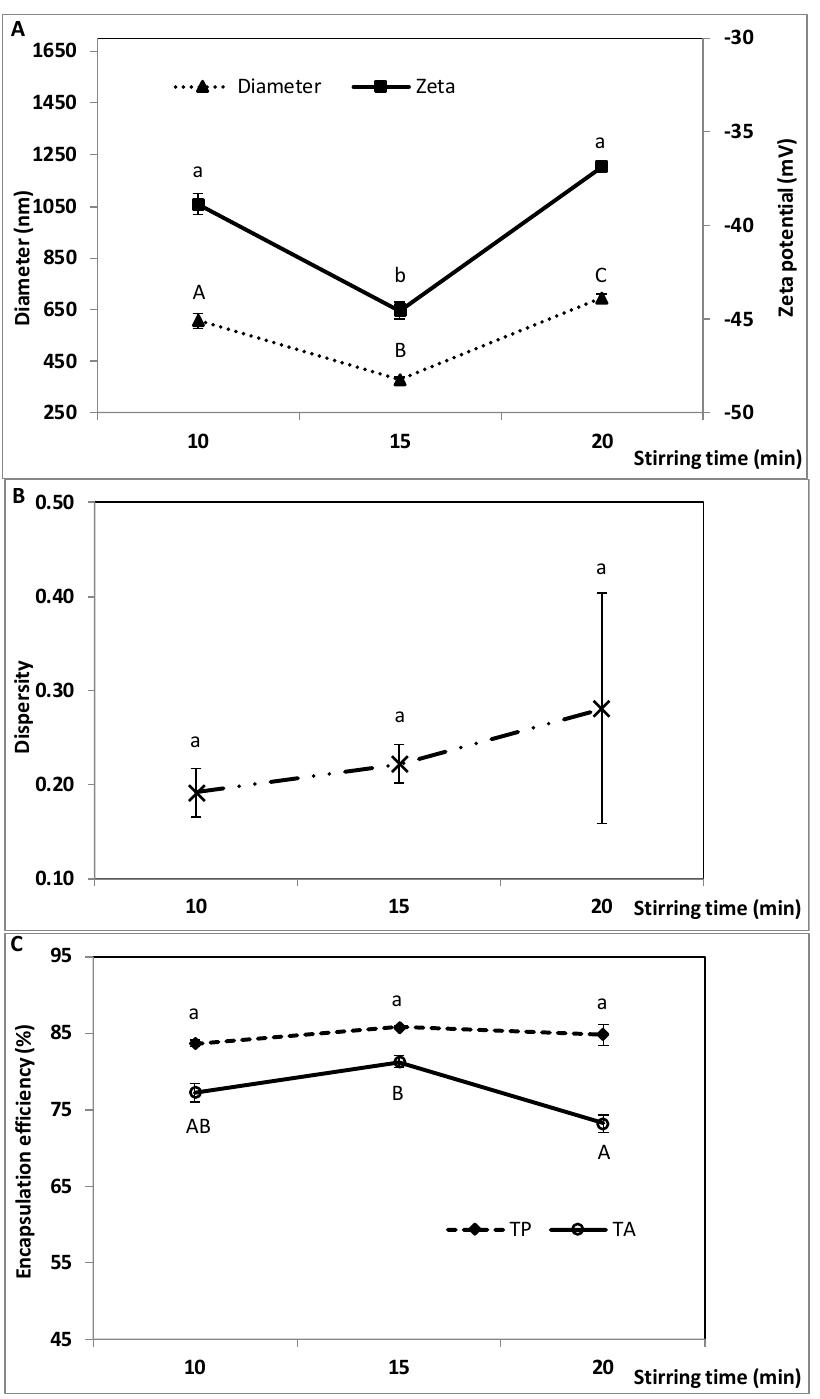
Figure 3. Effect of W 1 /O/W 2 homogenization stirring time on the characteristics of the double emulsion, ( A ) droplet diameter, zeta potential, ( B ) size dispersity, and ( C ) encapsulation efficiency of total polyphenols (TP) and total anthocyanins (TA). W 1 /O homogenization speed and time: 10,000 rpm and 10 min; W 1 /O/W 2 homogenization speed and microfluidization pressure: 6000 rpm and 50 MPa. Means (three replicates) ± SD. Means with different letters in each series are significantly different ( p ≤ 0.05).